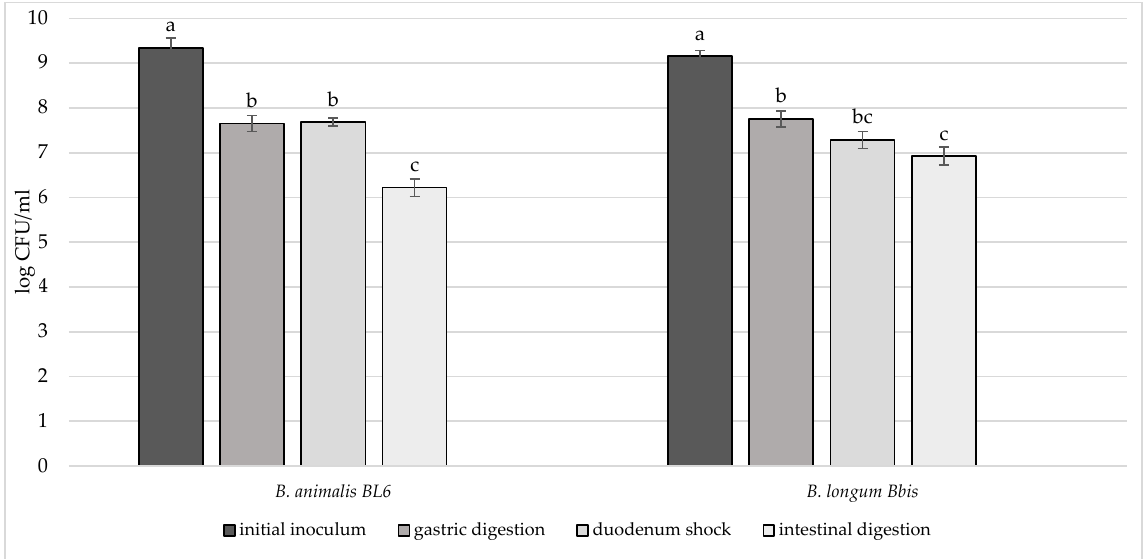
Figure 6. Cell loads of B. animalis BL6 and B. longum B. Bis after the simulated stomach–duodenum passage, performed immediately after the inoculation in milk. Samples with different letters are significantly different ( p < 0.05).